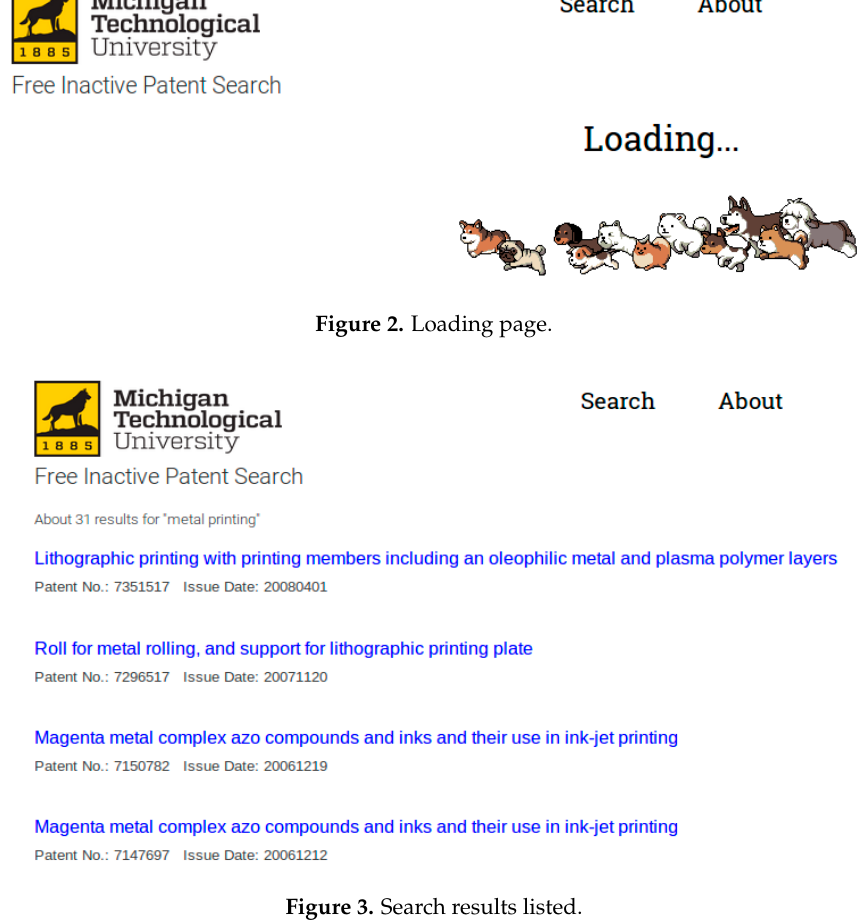
Figure 3. Search results listed.